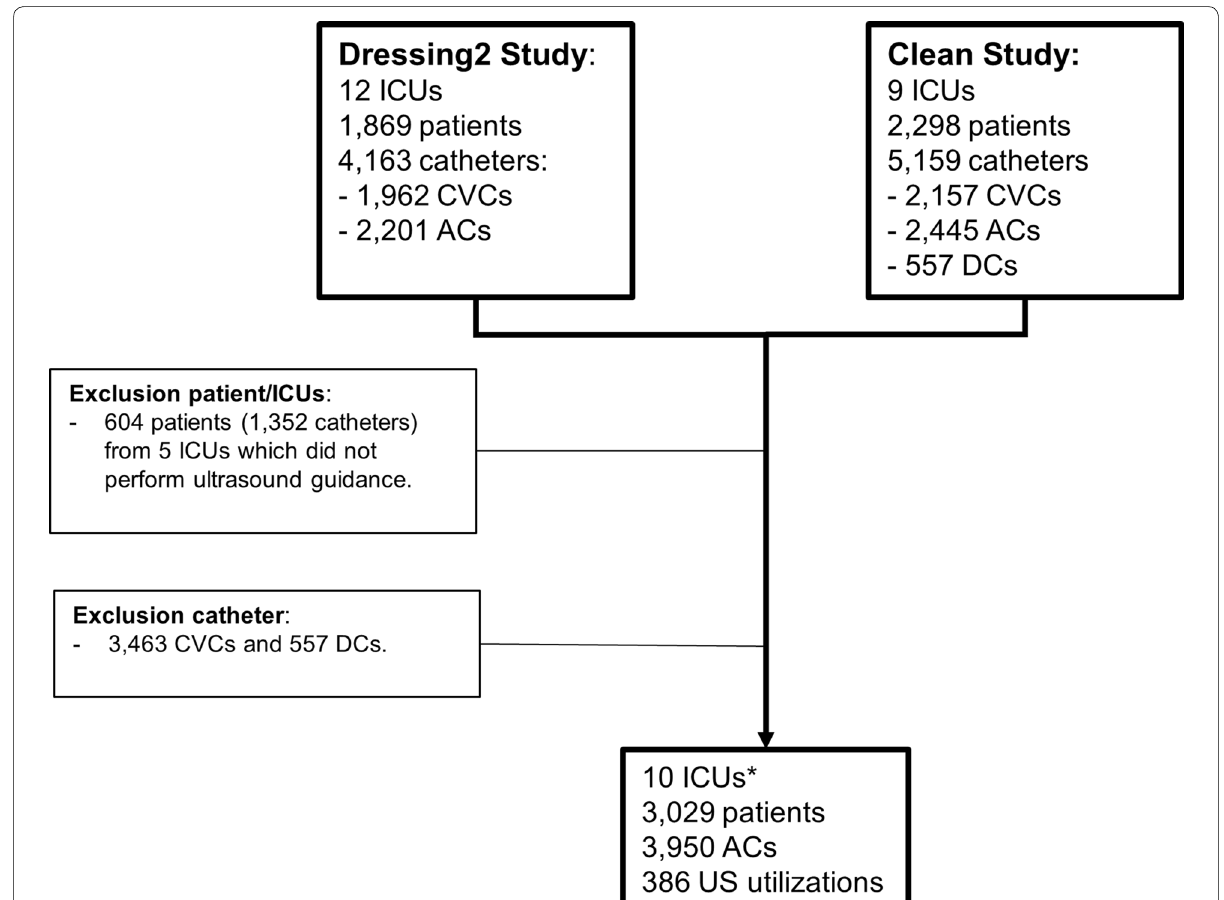
Fig. 1 Flow chart. ICU intensive care unit, CVC central venous catheter, AC arterial catheter, DC dialysis catheter, US ultrasound guidance. *6 ICUs were included in both